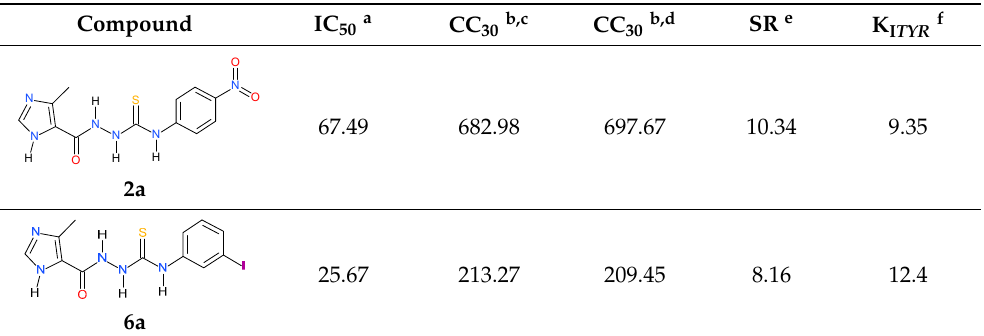
Table 1. The inhibitory concentrations (IC 50 ) against Toxoplasma gondii and cytotoxic concentrations (CC 30 ) against L929 and Hs27 cell lines of 2a and 6a .